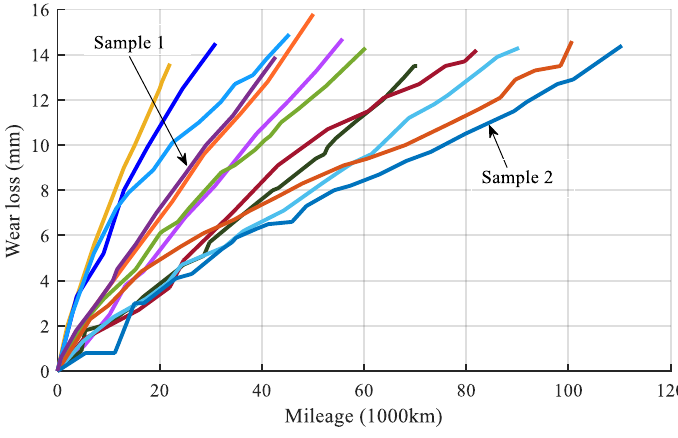
Figure 8. The wear path of H type for PCCS.